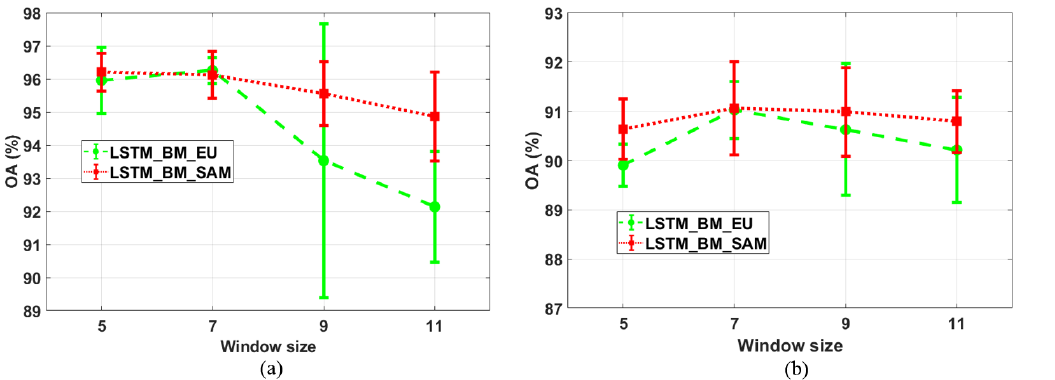
Figure 7. Analysis of different window sizes. ( a ) OAs based on the Pavia University image data; and ( b ) OAs based on the Salinas image